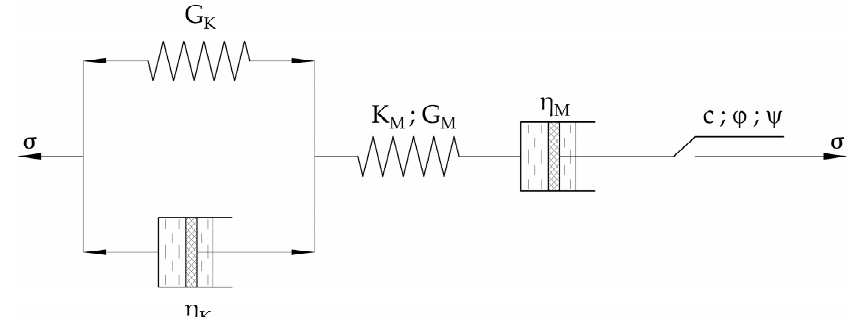
Figure 2. A classic Burger’s creep viscoplastic model, redrawn from [35].